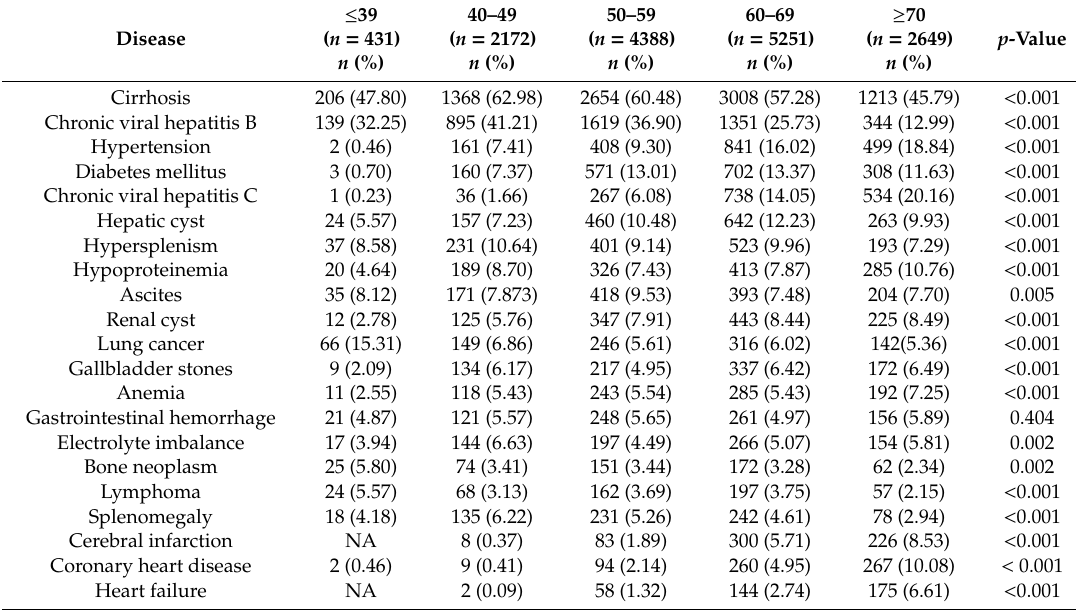
Table 3. Prevalence of comorbidities by age category (years).